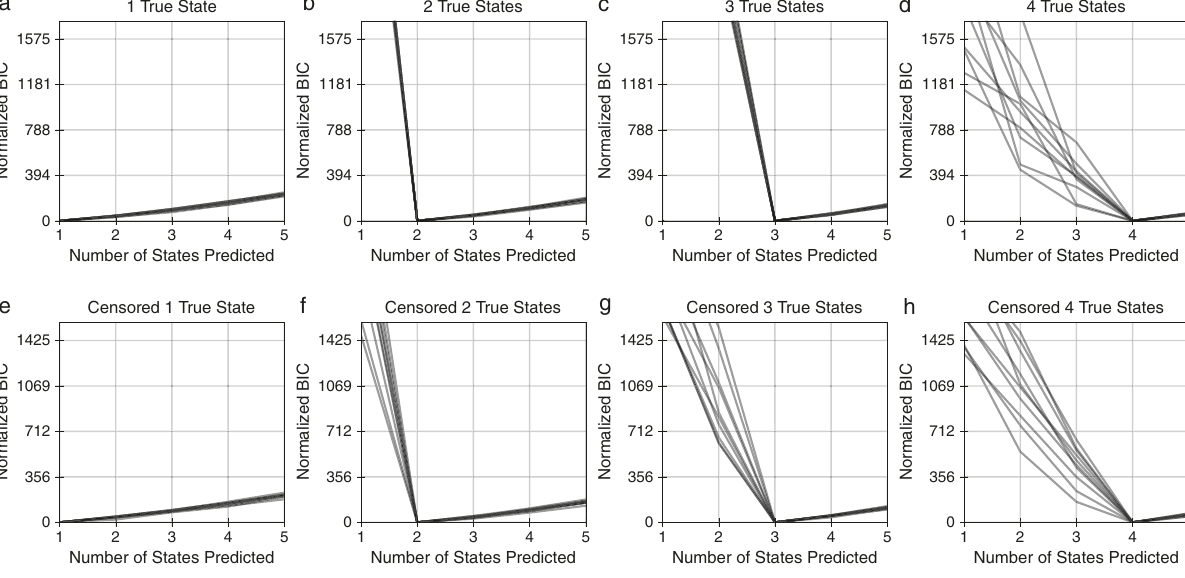
Fig. 6 Model selection effectively identi fi es the number of distinct states in synthetic data. a – d Model BIC for synthetic uncensored lineages with 1 – 4 true states. e – h Model BIC for synthetic censored lineages with 1 – 4 true states. BIC values are normalized such that the optimum is equal to 0. The minimum BIC value corresponds to the predicted number of states in each repetition. 10 trials